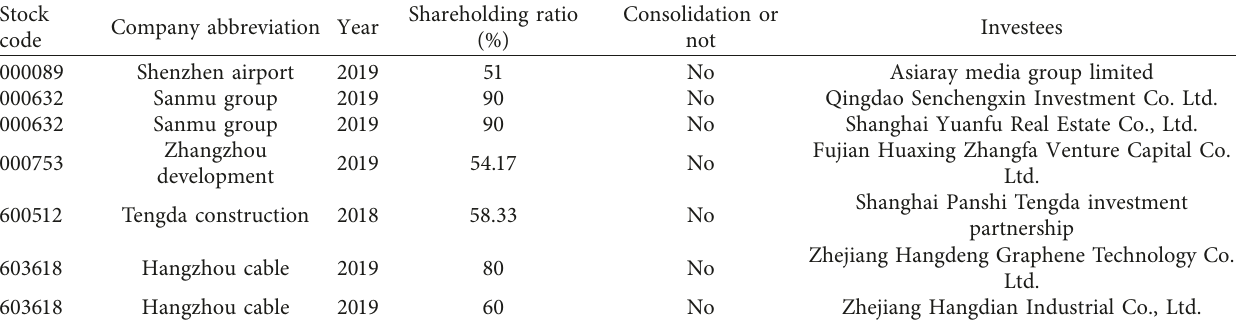
Table 2: Statistics of the relationship between shareholding ratio and consolidation (shareholding ratio >